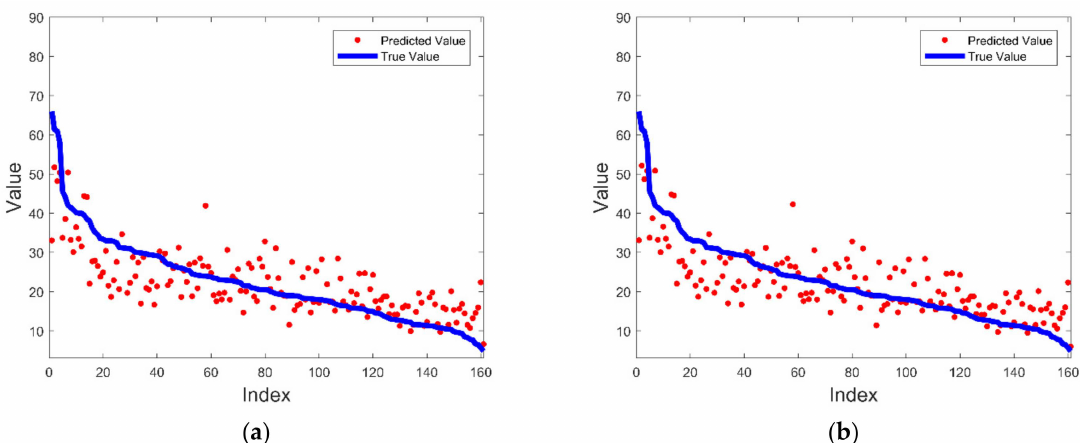
Figure 11. Real estate transaction dataset prediction results obtained with the models fused with the numeric-type spatial weight matrix: ( a ) conventional LS-SVR model; ( b ) Geo LS-SVR